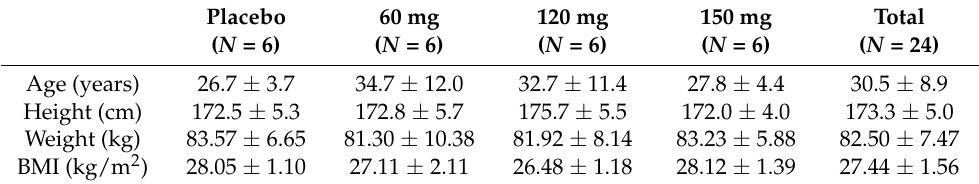
Table 1. Demographic summary of